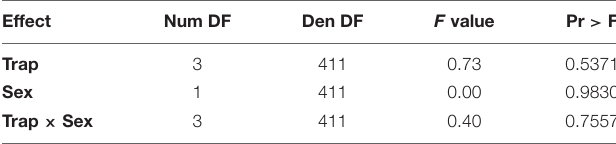
TABLE 9 | Type 3 analysis of effects of flies from Piedmont Research Station blackberry plot.